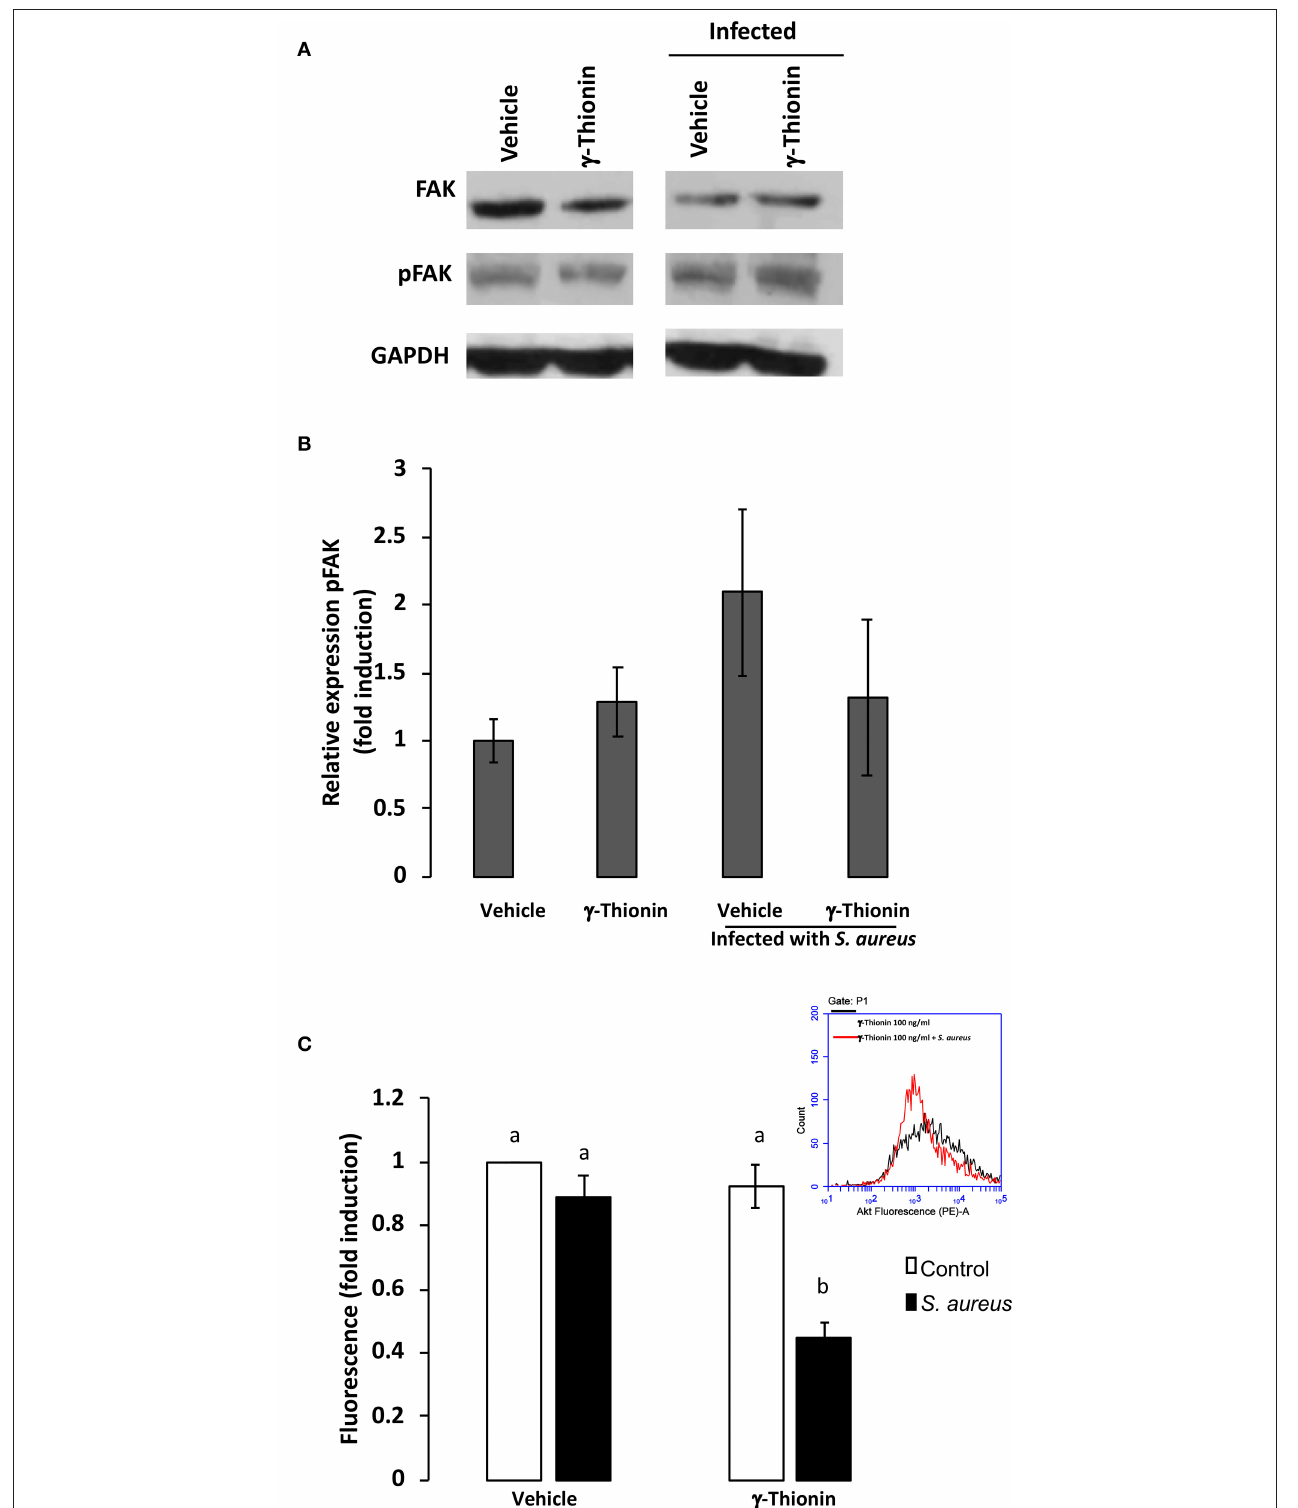
FIGURE 2 | AKT is down-regulated by γ -thionin and S. aureus in bMECs. (A) Western blot analysis from cell lysates of bMECs treated 24h with γ -thionin (100ng/ml) with or without S. aureus infection for 2h. Lysates were immunoblotted for total-FAK, phospho-FAK, or GAPDH as control. DMSO 0.02% was used as vehicle. (B) Densitometrical analysis of the immunoblots that shows the relative expression of pFAK with respect to total-FAK. Each bar shows the mean ± SD of optical density